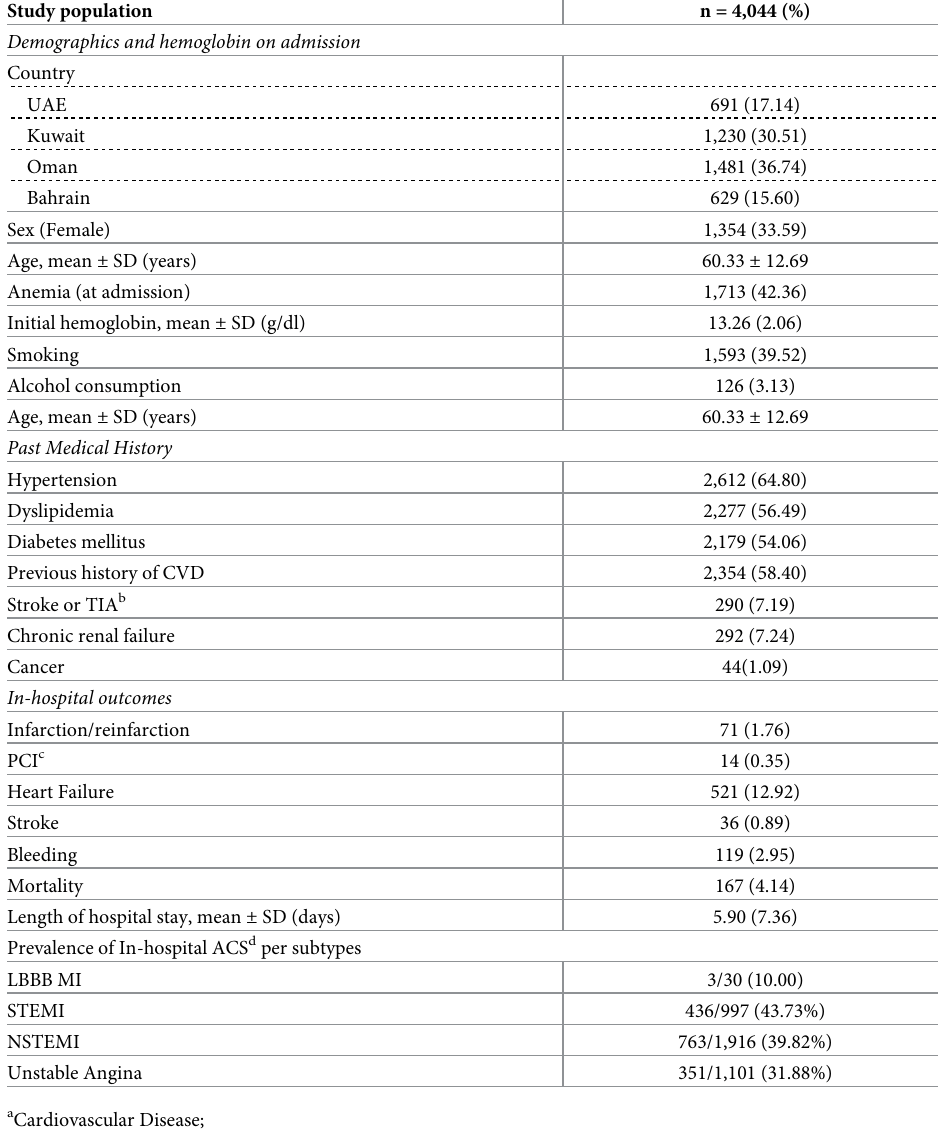
Table 1. Baseline characteristics of Gulf-COAST